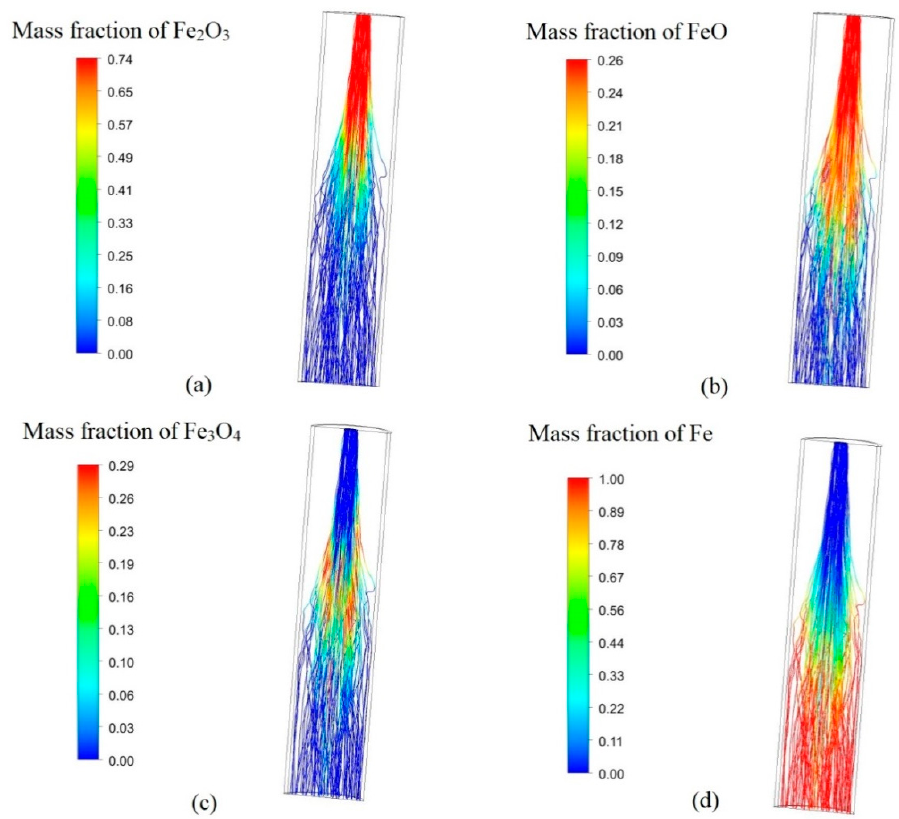
Figure 8. Particle trajectories and component contents in the reaction shaft; ( a ) Fe 2 O 3 ; ( b ) FeO; ( c ) Fe 3 O 4 ; and ( d ) Fe.